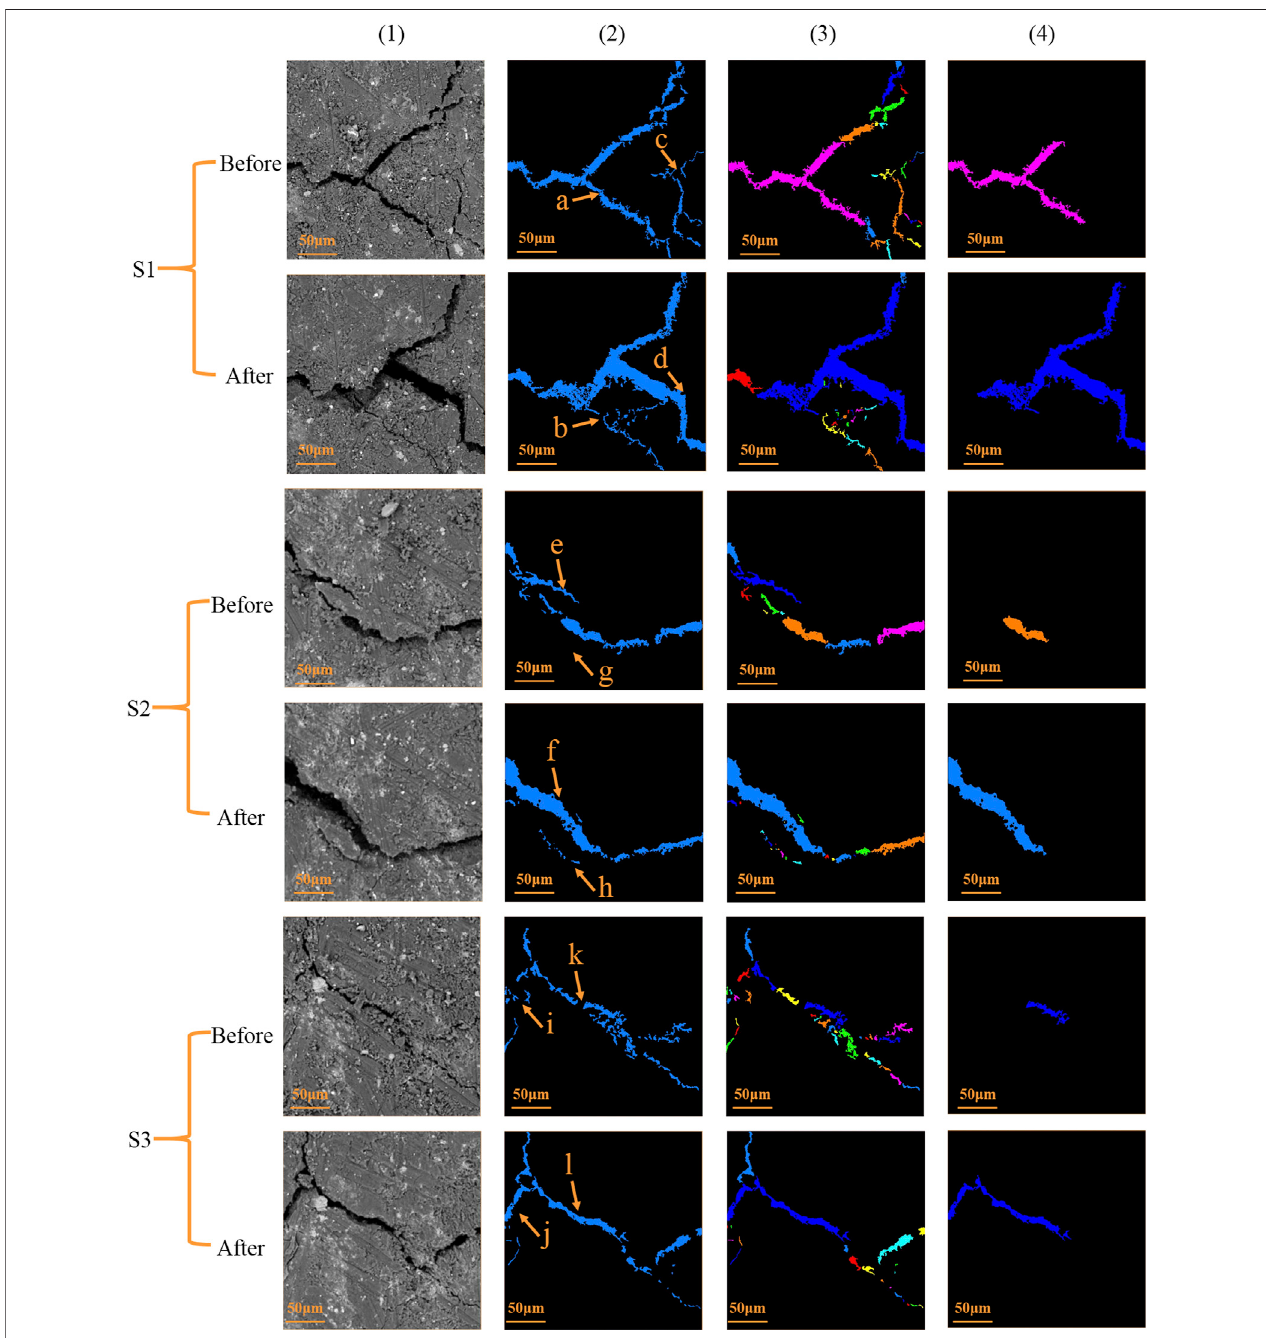
FIGURE 3 | Comparison of cleat shape and size before and after the reaction: (1) the original SEM image, (2) extracted cleat, (3) individual cleats, and (4) extracted largest cleat.